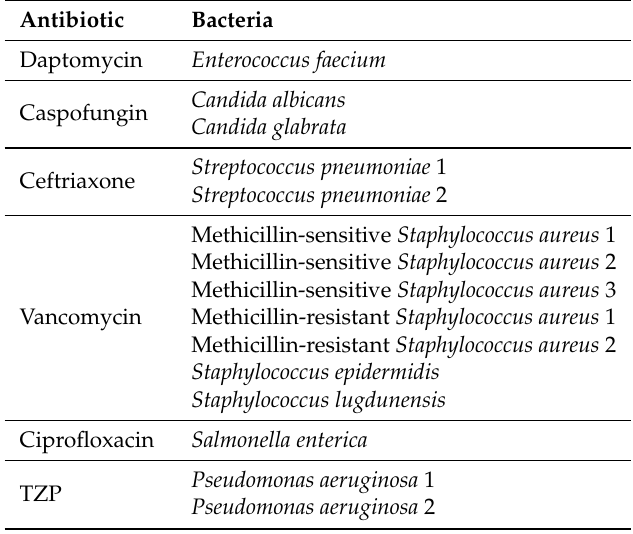
Table A1. Bacterial classes used as OOD for each